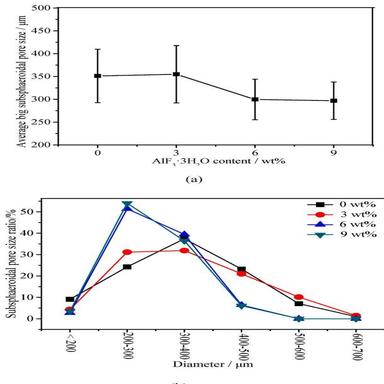
(a) Mean size of large subspheroidal pores and (b) subspheroidal poresize distribution.